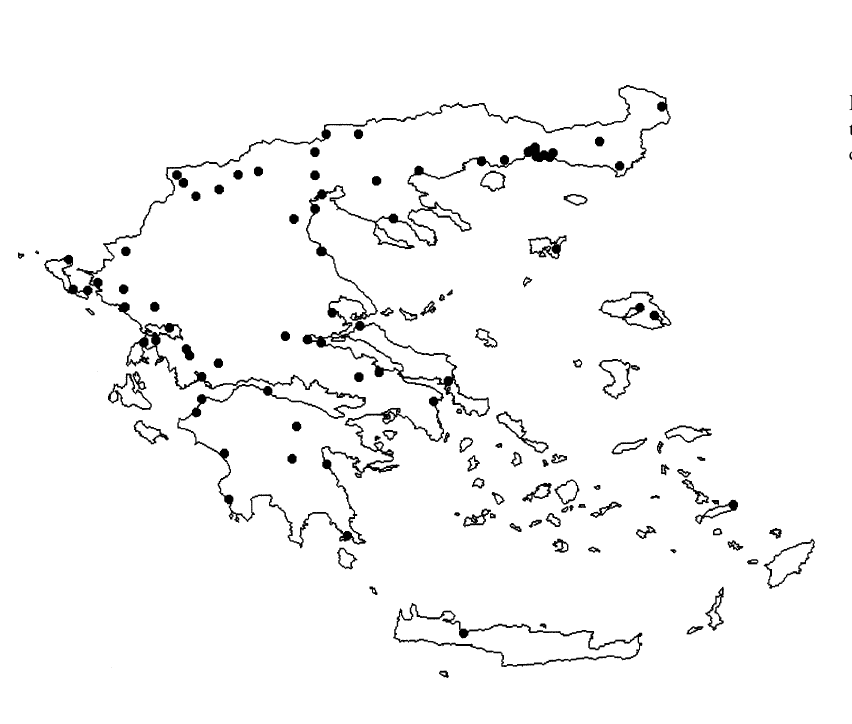
Fig. 1. The Greek wetlands from the Corine database that were in- cluded in the study (71